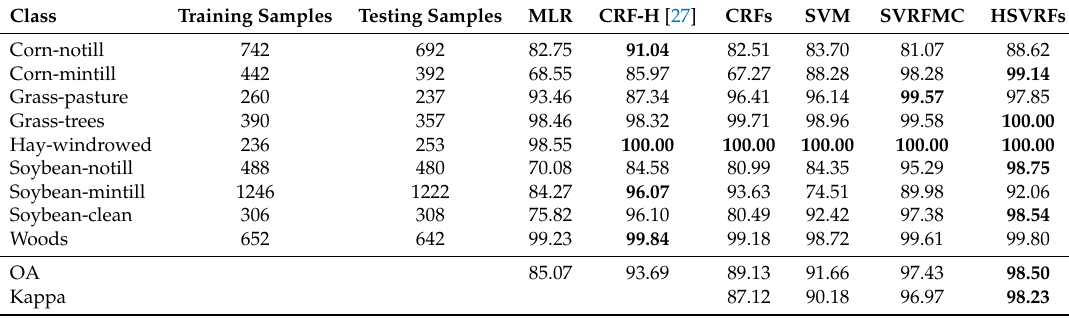
Table 2. Classification accuracies of the different algorithms for the Indian Pines dataset (%).